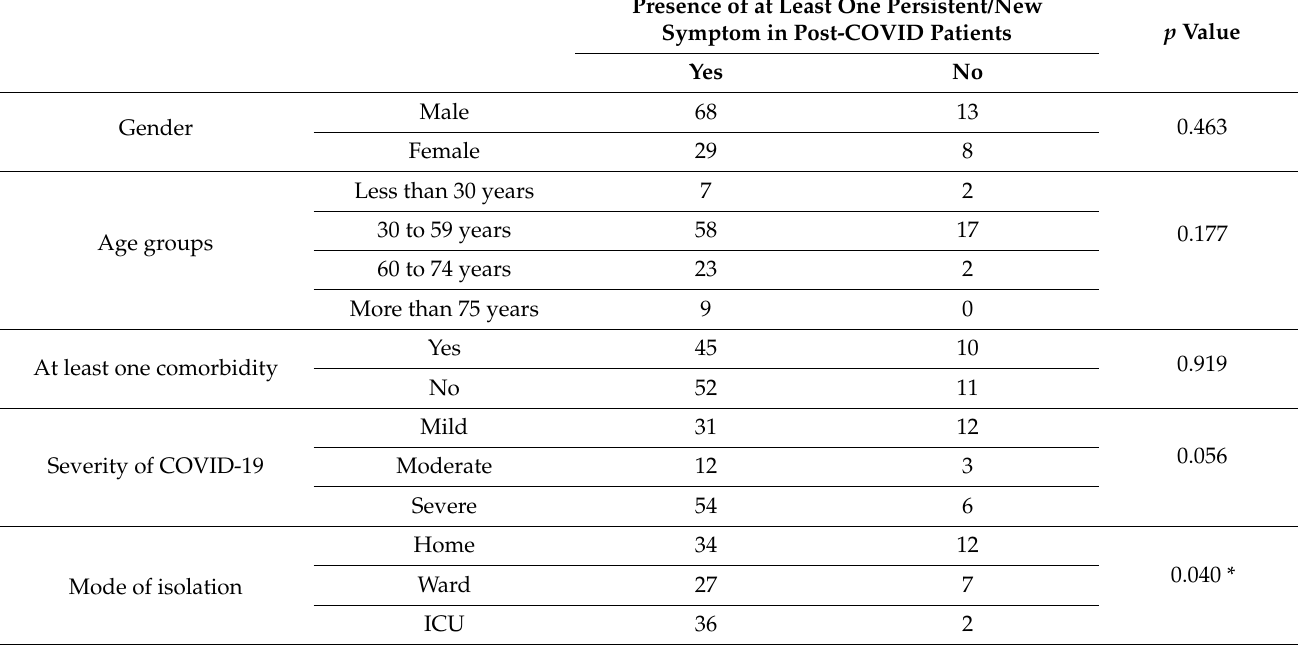
Table 6. Association of the presence of at least one persistent/new symptom in post-COVID-19 patients with baseline characteristics